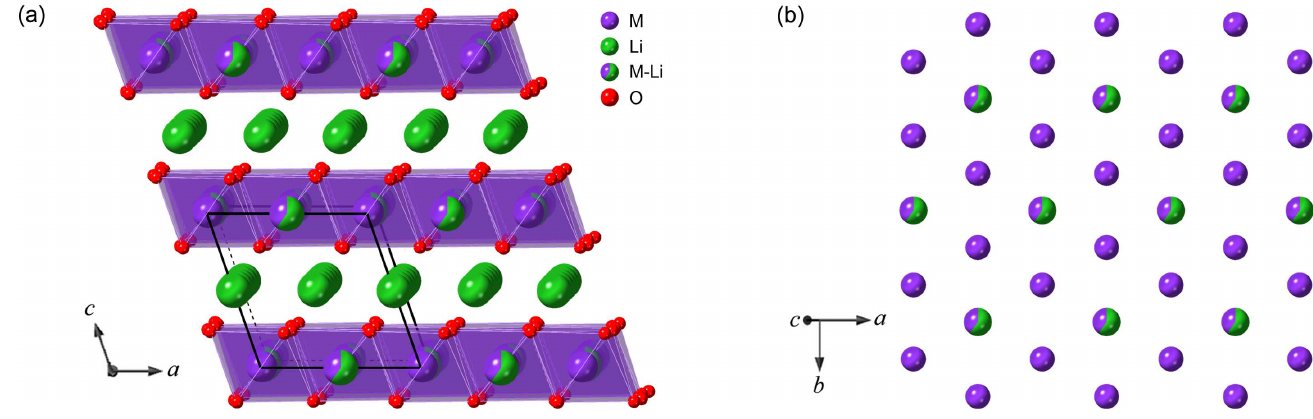
Figure 1 ( a ) Crystal structure of layered LMR-NMC observed along the [010] direction of the monoclinic C 2/ m unit cell (indicated in black). Purple octahedra represent MO 6 octahedra, with M = Ni, Mn, Co. ( b ) Honeycomb ordering of the lithium-rich positions in the TM layers. Green, purple and red spheres represent lithium atoms, TM atoms and oxygen atoms,